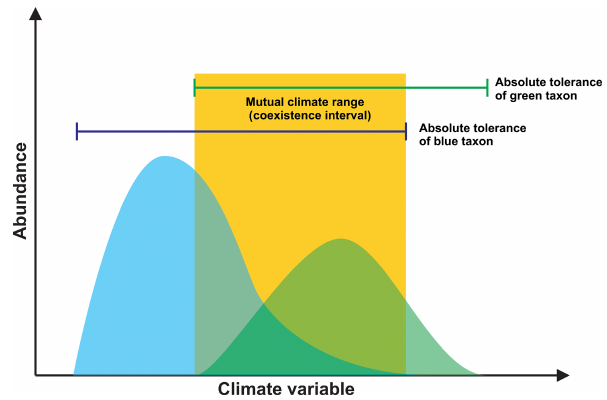
Figure 1. The concept of the mutual climate range as used in the Coexistence